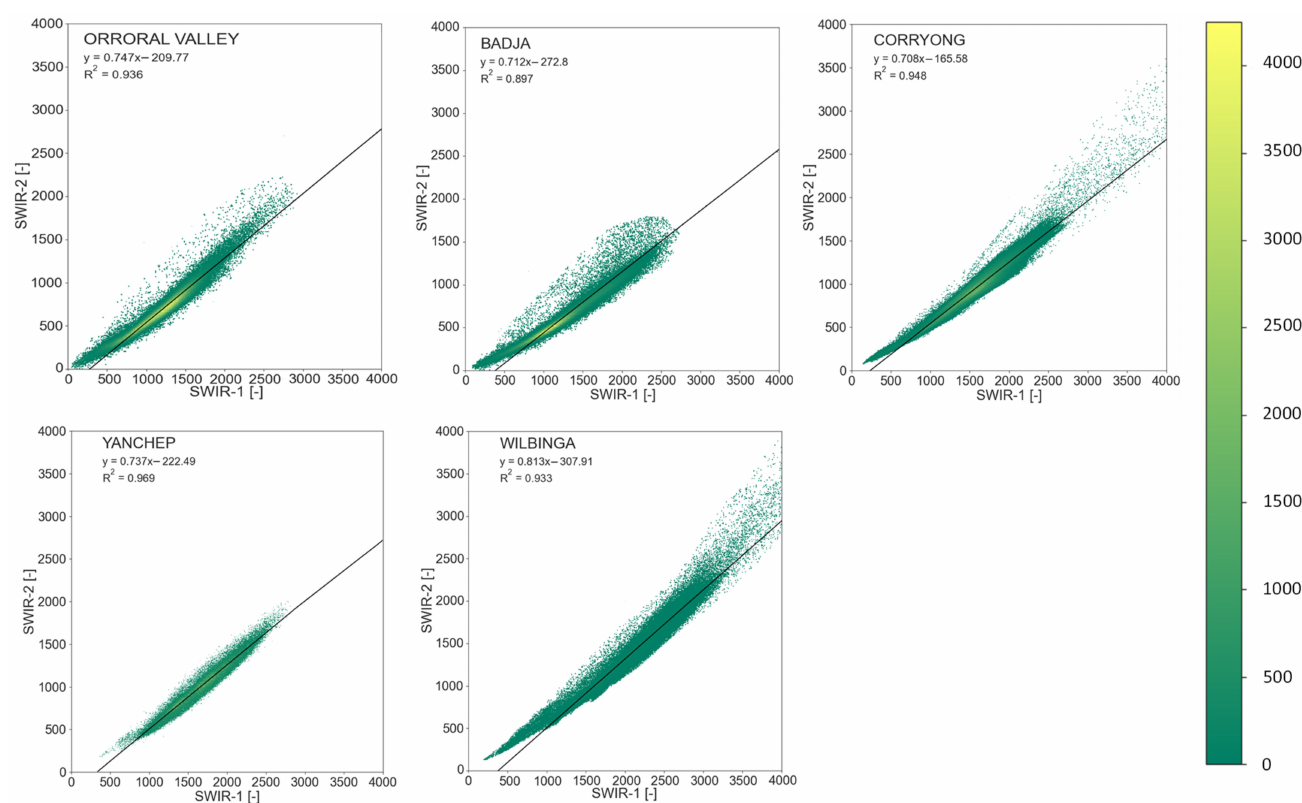
Figure 8. Density plots and linear vegetation lines from the scaled surface reflectance in the SWIR-1 (1.6 µ m) and SWIR-2 (2.2 µ m) bands from Sentinel-2 for different wildfires in South-Eastern Australia. Orroral Valley (Australian Capital Territory), Badja (New South Wales), Corryong (Victoria), Yanchep (Western Australia, and Wilbinga (Western